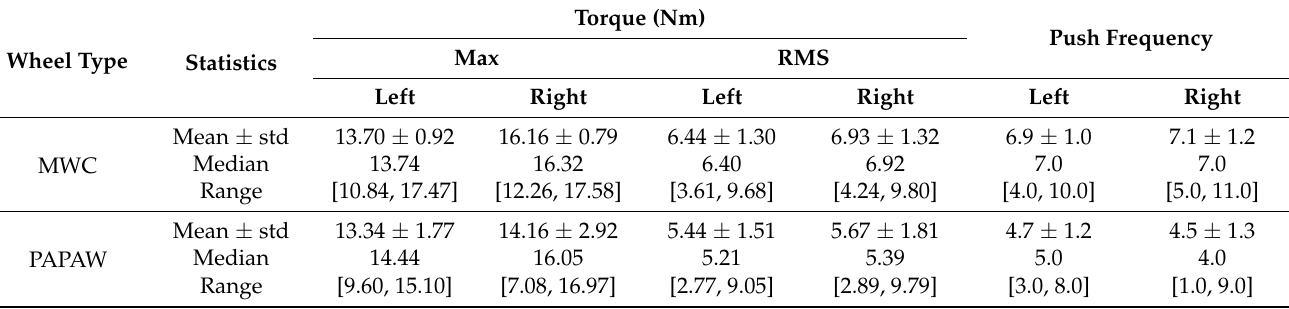
Figure 6. Summary of kinematic characteristics for all wheelchair maneuvers. Descriptive statistics of kinetic and kinematic measurements from MWC and PAPAW tests are reported in Tables 5 and 6, respectively. Results of the Wilcoxon signed-rank tests comparing the kinetic/kinematic features between MWC and PAPAW tests are presented in Table 7. We found that three kinetic features (RMS torque of the left and right wheel, max torque of the right wheel) were significantly lower when using PAPAWs. All kinematic features, that are max/RMS of linear and angular velocity, were significantly higher for PAPAWs compared with MWC tests. The average number of pushes on each wheel was significantly reduced when using PAPAWs. Table 5. Descriptive statistics of kinetic measurements (N = 200).